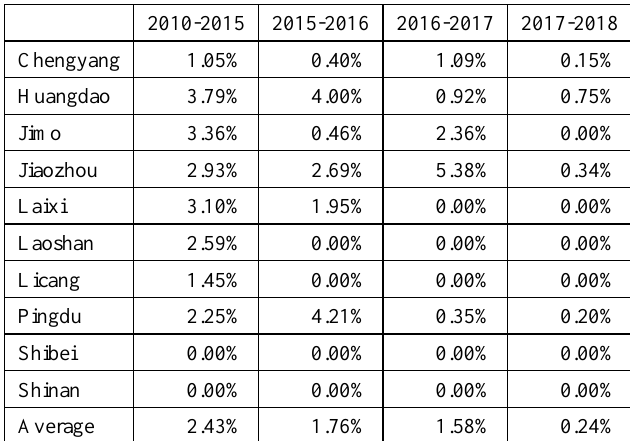
Table 2 . Urban land areas from 2010 to 2018 of different districts and county-level cities in Qingdao city.